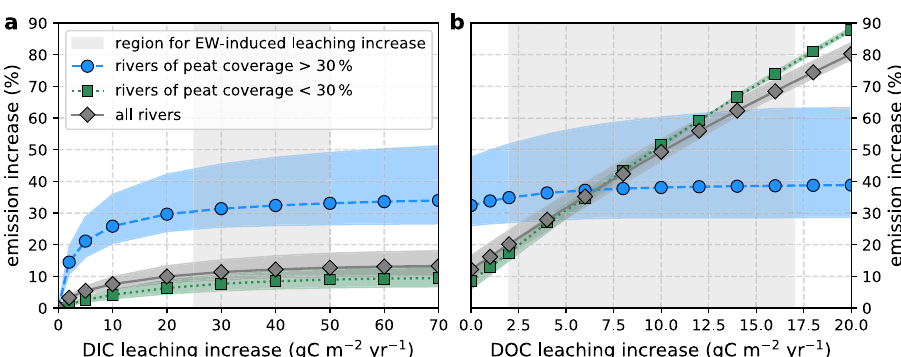
Fig. 3 River emission response to enhanced weathering. Response of river CO 2 emissions to EW as derived using the river box model. The emission increase was calculated for a increased DIC leaching and b increased DOC leaching in addition to an exemplary DIC leaching increase of 40 gC m − 2 year − 1 . Gray shaded areas indicate the estimated region for the EW-induced leaching increase. Shaded areas around the data points represent uncertainty based on best/worst case scenarios, as the errors of the decomposition parameters have been integrated throughout box model